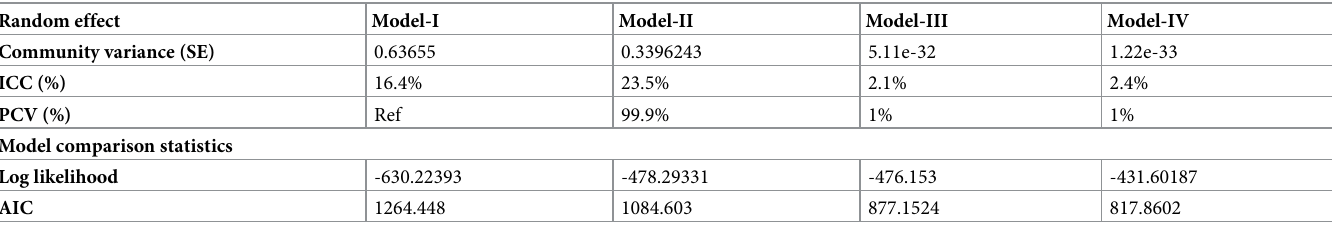
Table 5. Parameter coefficients and model comparisons of each successive model in FoI of YFS, Central Gondar Zone, 2019.